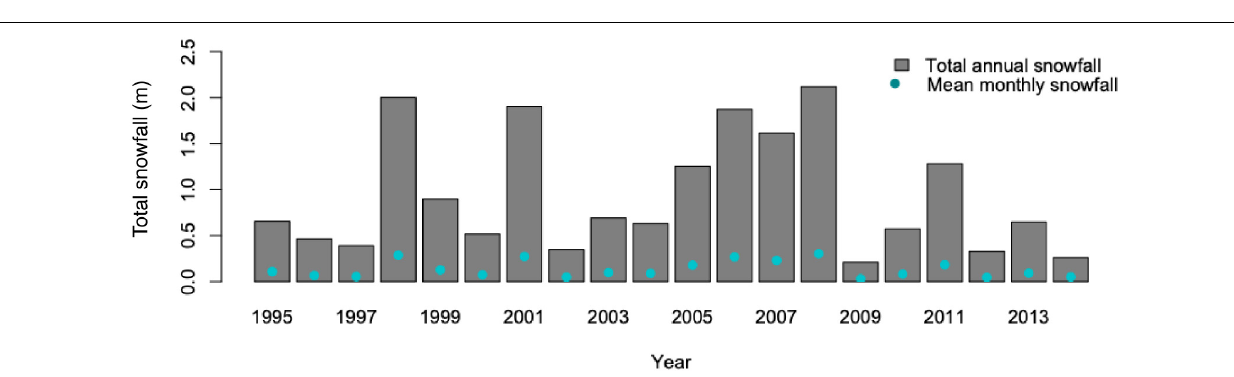
FIGURE 2 | Total annual snowfall recorded at Annette Island, the closest long-term weather station to the study area in Southeast Alaska, United States, where Sitka black-tailed deer were monitored from 2010 to